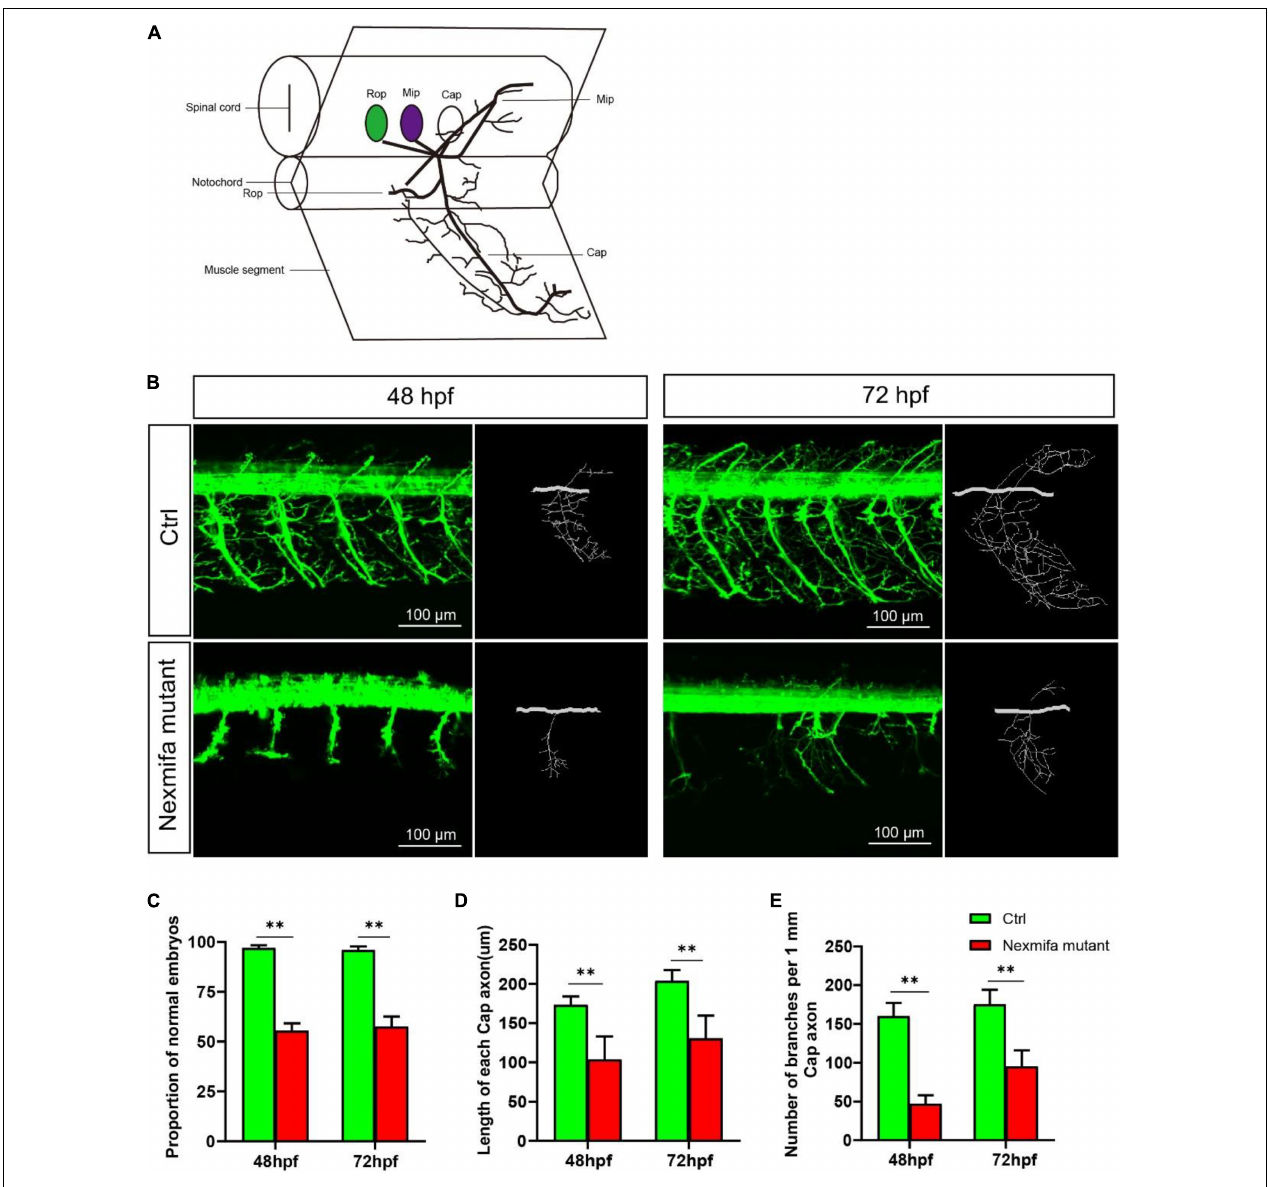
FIGURE 3 | Nexmifa affects motor neuron morphogenesis in nexmifa mutant zebrafish embryos. (A) The schematic for three different primary motoneurons (CaP, MiP, and RoP) in fish. (B) Confocal imaging of primary motor neurons in control and nexmifa mutant groups at 48 and 72 hpf. Scale bar = 100 µ m (C) The percentage of embryos with normal PMNs in control and nexmifa mutants at 48 hpf ( n = 125 and 240, respectively) and 72 hpf ( n = 132 and 235, respectively). (D) Cap length in control and nexmifa mutants at 48 hpf ( n = 20 and 31, respectively) and 72 hpf ( n = 15 and 28, respectively). (E) Number of branches per 1 mm Cap axon in control and nexmifa mutants at 48 hpf ( n = 8 and 10, respectively) and 72 hpf ( n = 9 and 12, respectively). Bar represent the mean ± standard deviation (SD). ∗∗ p <